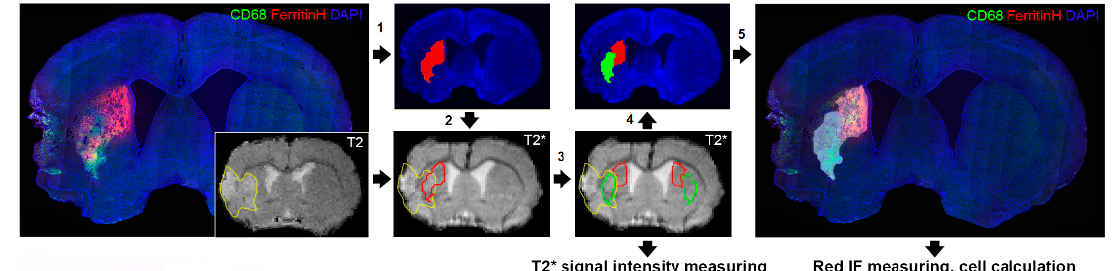
Figure 11. The processing steps in analysis of MRI and fluorescent images: ( 1 ) creating a binary image based on a fluorescent micrograph, ( 2 ) reducing the dimension of a binary image to the dimension of T2* image, ( 3 ) separation of brain zones based on the signal hyperintensity on T2-weighted images following by T2* signal intensity measurement, ( 4 ) scale-up regions of interest (ROIs) to measure IF and calculate labeled cells in micrographs ( 5 ).